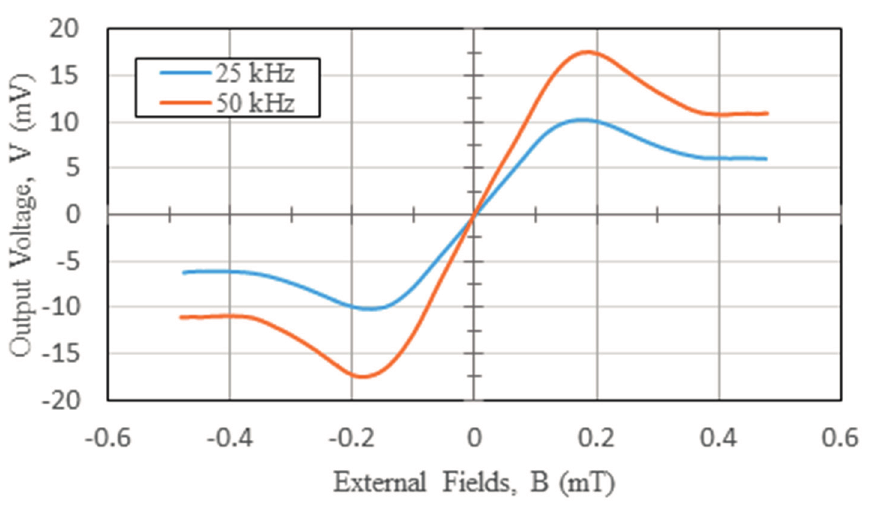
Figure 14. The V-B diagram close to zero magnetism at different excitation frequencies in